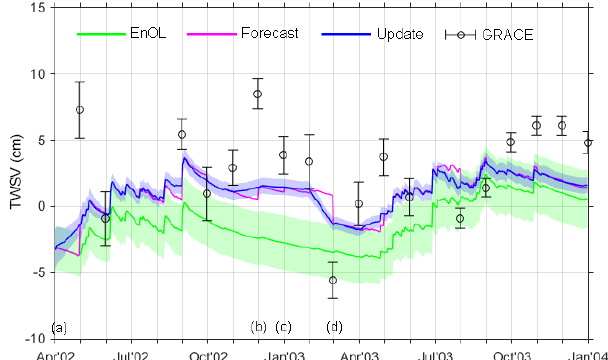
Figure 9. Daily TWS variations estimated between 1 April 2002 and 31 December 2003, averaged over Shiyang River basin. The mean value of the ensemble is given as the solid line, and the stan- dard deviation is shown as the shaded envelope. The TWS estimates from model only (EnOL), GRACE DA forecast (EnKF before the update), GRACE DA update (EnKF after update), and GRACE ob- servations are shown. The x -axis labels represent the first day of the month. Some features of the DA scheme regarding the identical TWS estimate seen at the beginning of the update (point a) and the observed spurious jumps (points b, c, d) are also